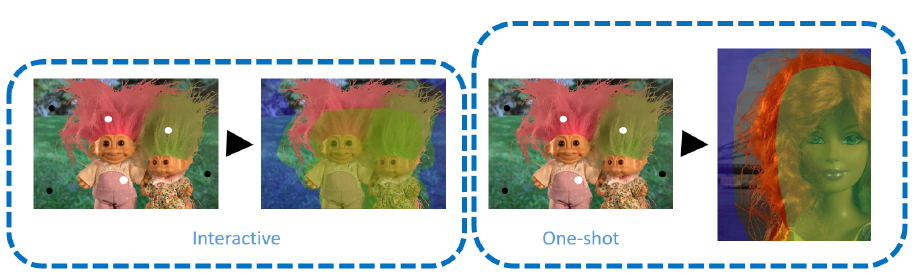
Figure 3. The main differences between interactive methods and our method. Interactive-based methods cannot propagate annotations across different images, However, the proposed method can pass the annotations’ information between images of the same semantic